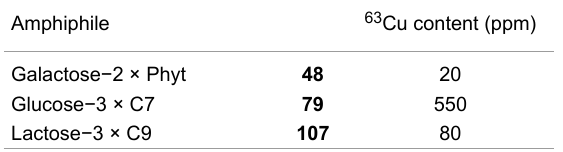
Amphiphile 63 Cu content (ppm)